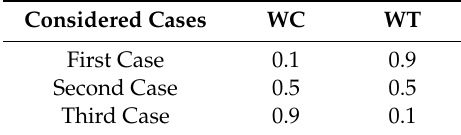
Table 1. The three considered cases for manually set feature weights.